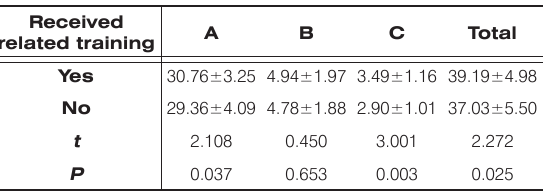
Table 6. Comparison of the evaluation scores of clinical nursing studies by authors with and without related training Note: A: Level of the study; B: Value of the result; C: Effectiveness of the result.